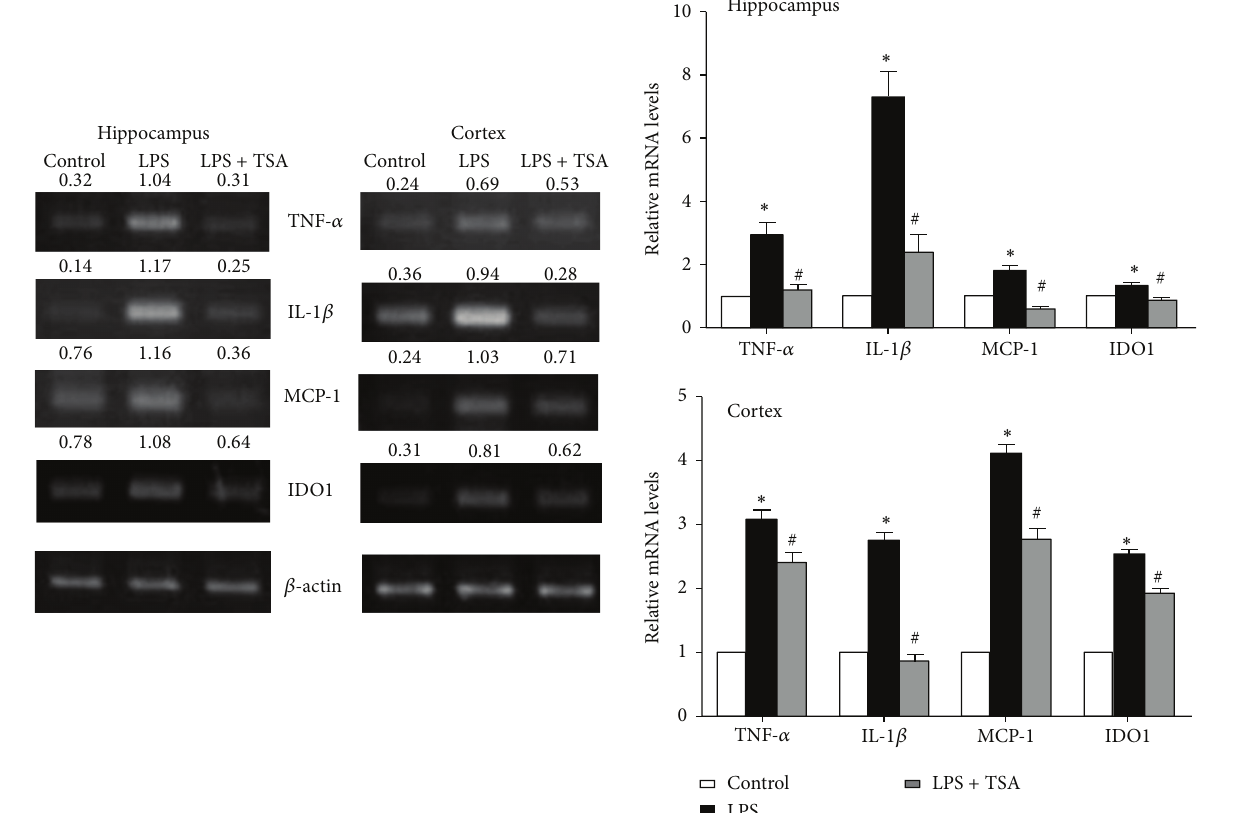
Figure 4: TSA attenuated LPS-induced cytokine mRNA expression in the hippocampus and cortex of mice. Mice were pretreated with saline (Controls) or TSA (0.3mg/kg) for 1h and then intraperitoneally challenged with saline or E. coli LPS (1mg/kg) ( 𝑛 = 6 in each group). After 24 h they had been treated with LPS, TNF- 𝛼 , IL-1 𝛽 , MCP-1, and IDO mRNA expression in the hippocampus and cortex of mice determined using RT-PCR. The lower panel shows the quantification of mRNA expression from six independent experiments. ∗ 𝑃 < 0.05 compared with the Control group; # 𝑃 < 0.05 compared with the LPS-only